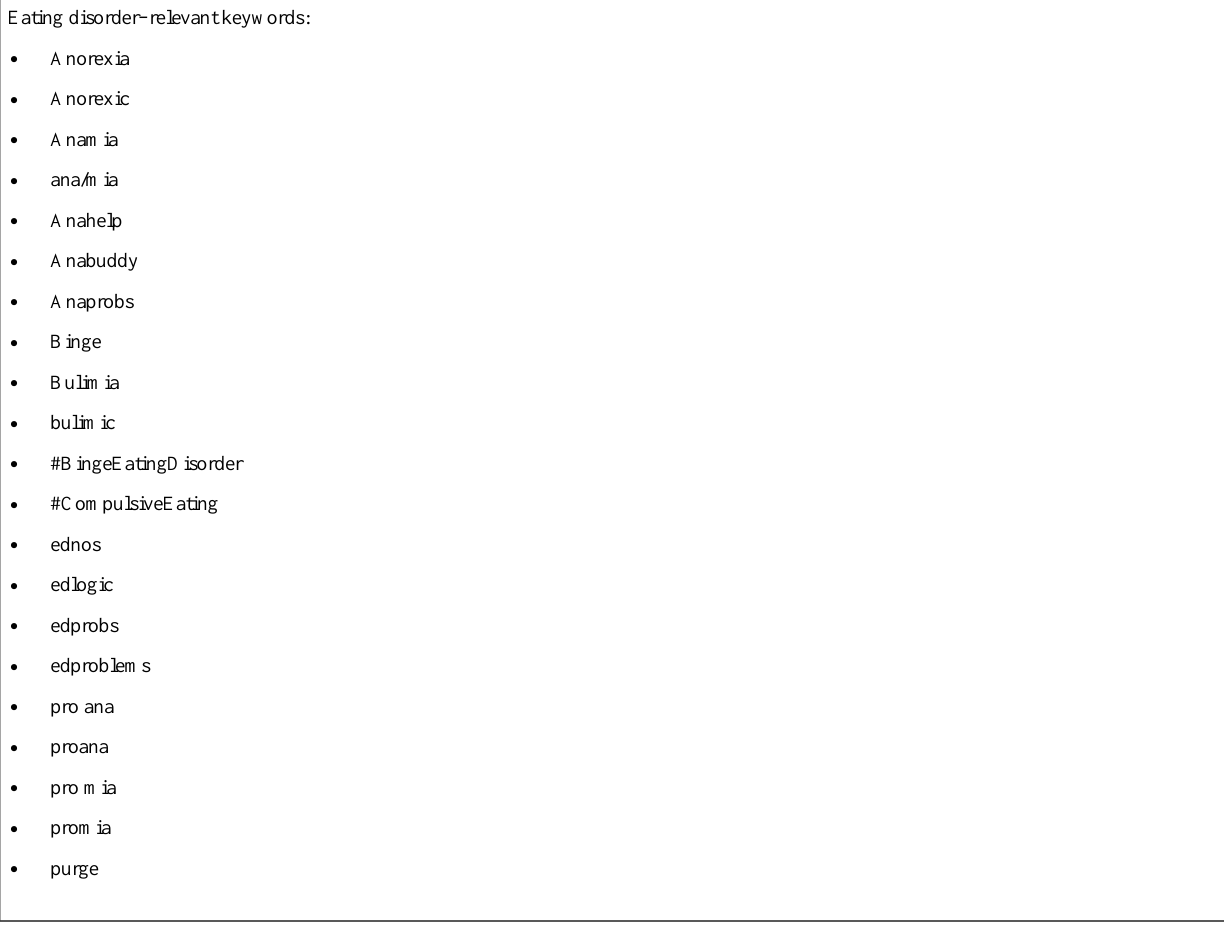
Textbox 1. List of eating disorder–relevant keywords refined from previous studies. Eating disorder–relevant